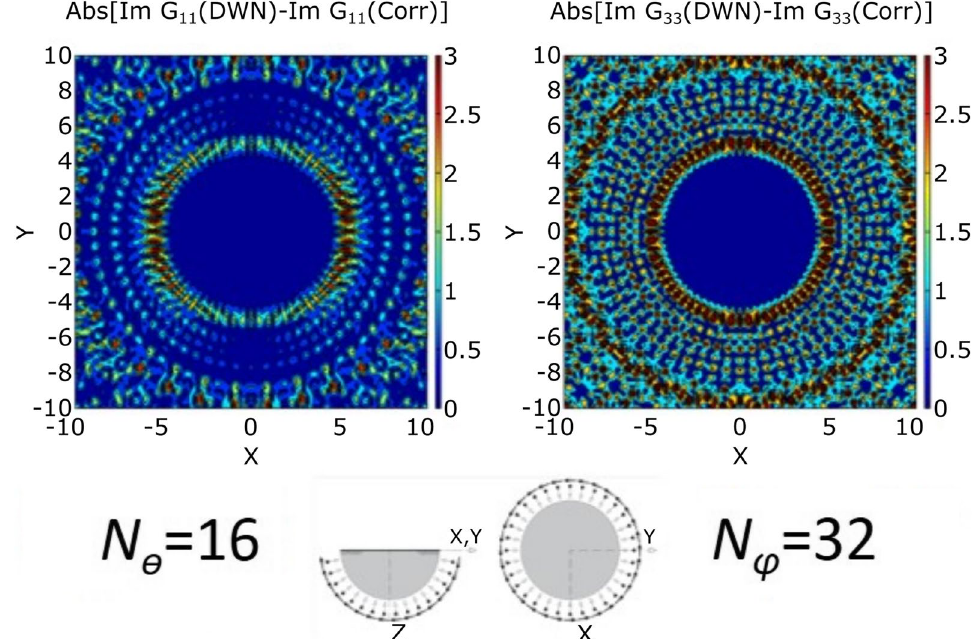
Fig. 4 Relative errors of surface results within a square for a horizontal and vertical unit harmonic forces, respectively. Illumination is given by N 16 and N φ 32. The square side has 20 wavelengths ө = =